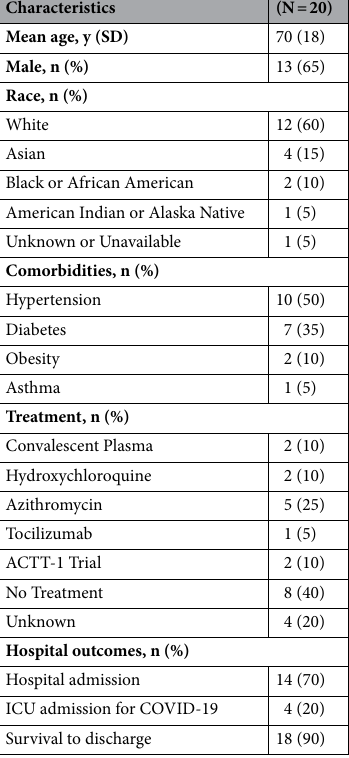
Table 1. Demographics and clinical characteristics of patients included in study. Different categories (in bold) and their subcategories are shown in the first column, with their respective number of patients in the second column. In parentheses, standard deviation is indicated in the first row, and percentages for all other